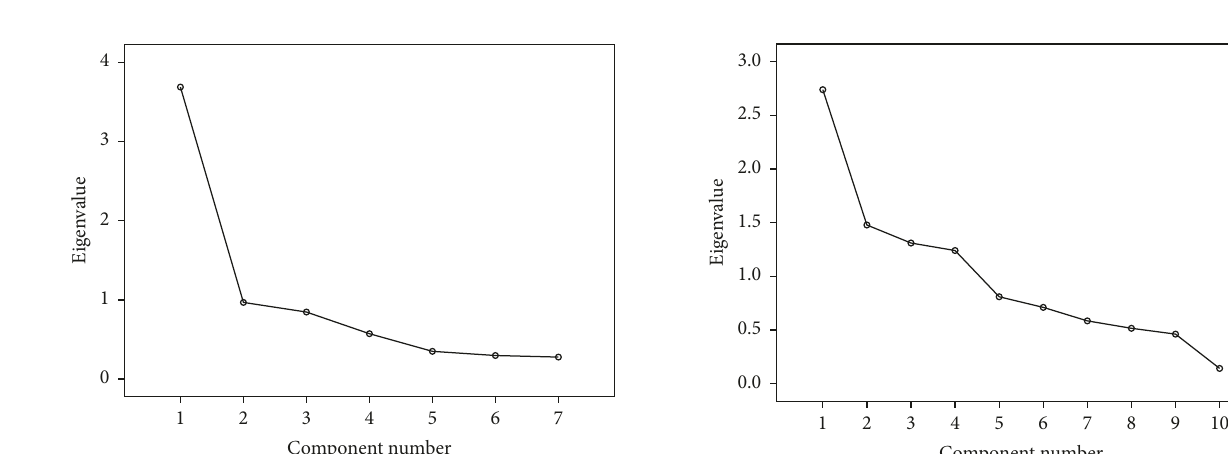
scores obtained in the pre- and postmeasures. The correlation coefficient scores being 0.82, 0.58, 0.61, and 0.74 for the four scales were all found to be highly significant at 0.001 levels suggesting adequate test-retest validity of the questionnaire (Table